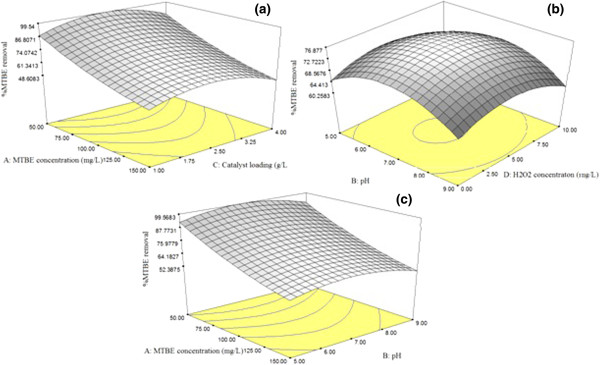
Effect of catalyst loading, Initial MTBE concentration, H2O2 concentration and pH on %MTBE removal. (a): pH=7, H2O2 concentration= 5 mg/L; (b): Initial MTBE concentration= 100 mg/L, Catalyst loading= 2.5 g/L; (C): Catalyst loading= 2.5 g/L, H2O2 concentration= 5 mg/L.